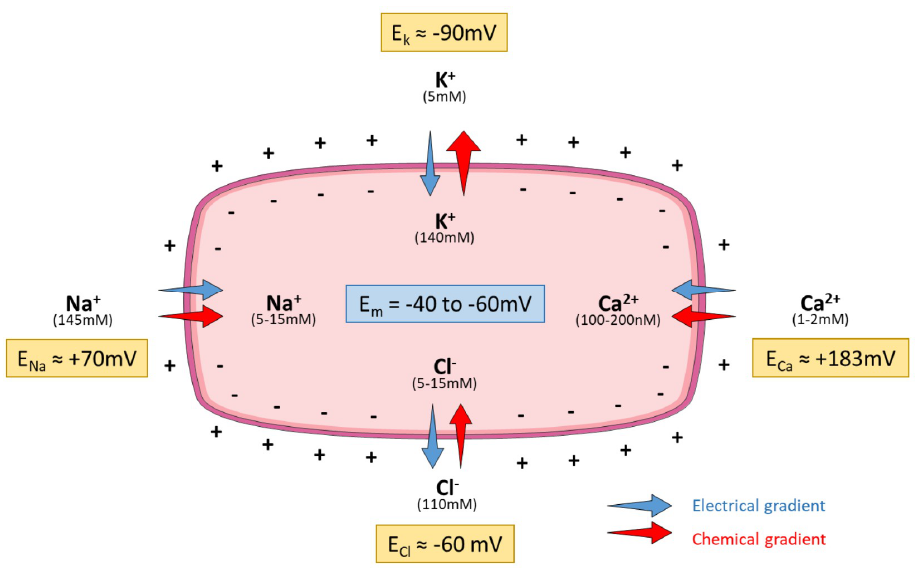
Figure 1. Concentration of the main ions (K + , Ca 2+ , Na + , Cl − ) in mammalian cell as well as their electrical and chemical gradients.